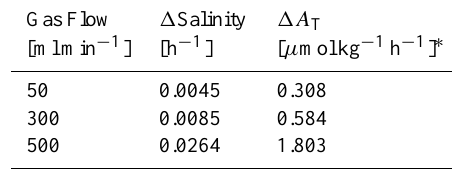
Table 2. Relationship between change of gas flow, salinity and A T